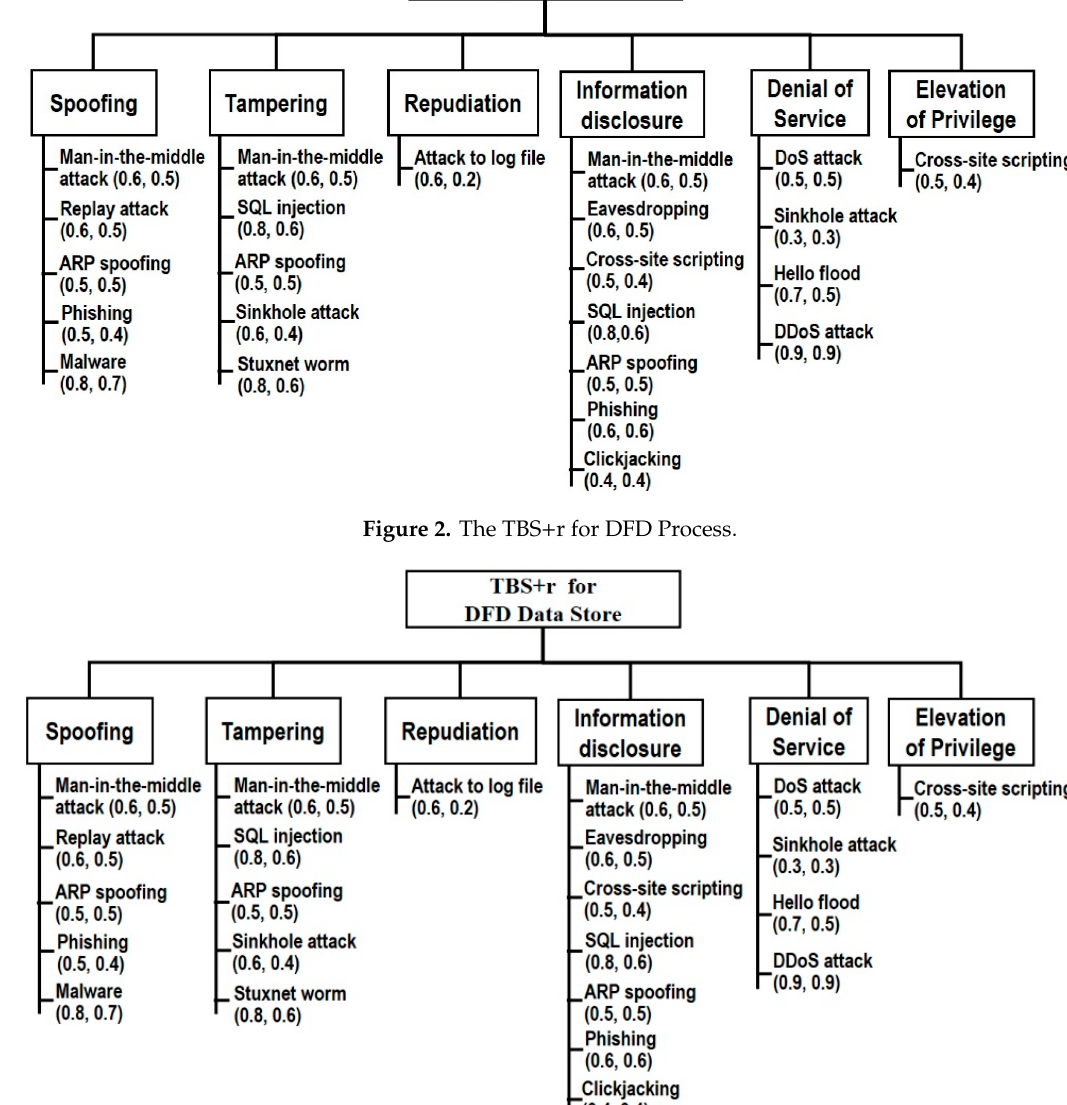
Figure 3. The TBS+r for DFD Data Store. Figure 3. The TBS + r for DFD Data